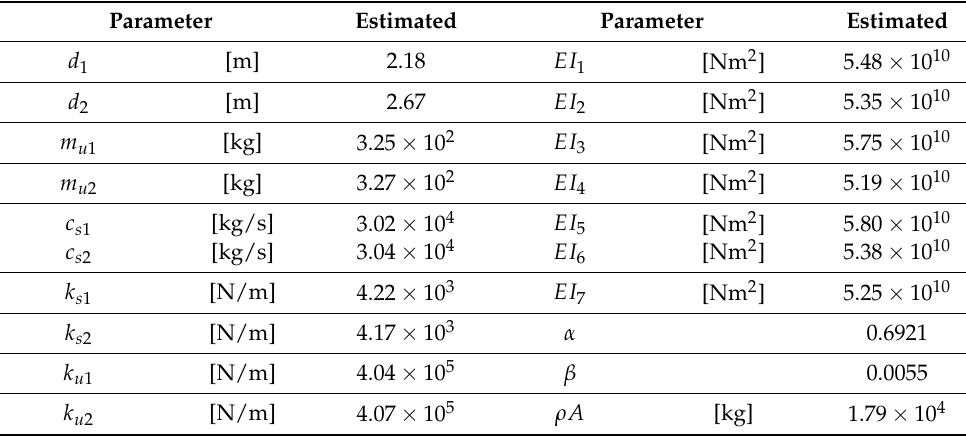
Figure 10. Comparison of estimated and measured PSD functions of road unevenness. Table 5. The estimated mechanical parameters of vehicle and bridge. Parameter Estimated